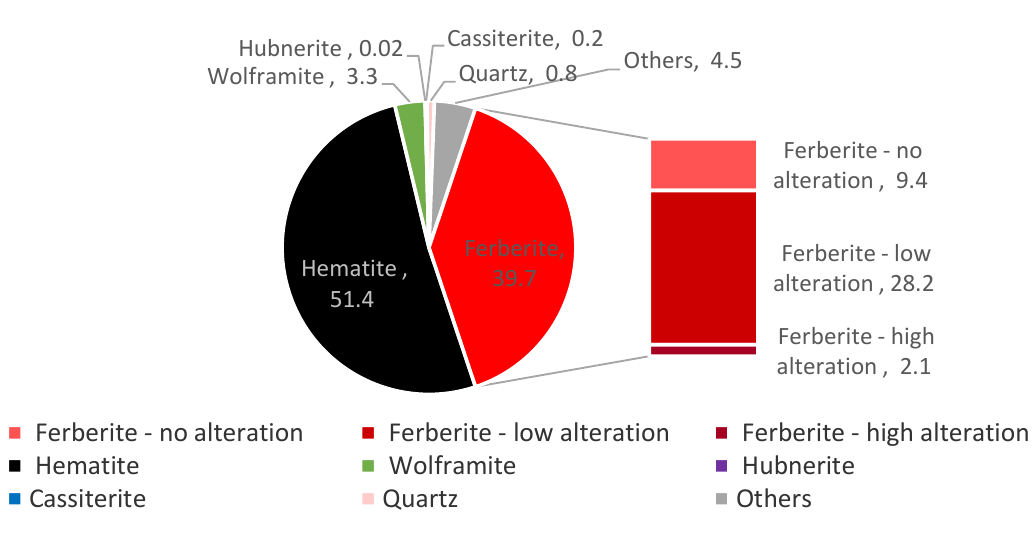
Figure 7. Summary of modal mineralogy of LIMS waste stream material based on QEMSCAN analysis. Table 3. Distribution of elements of interest in the LIMS magnetic waste material as measured by XRF and QEMSCAN.